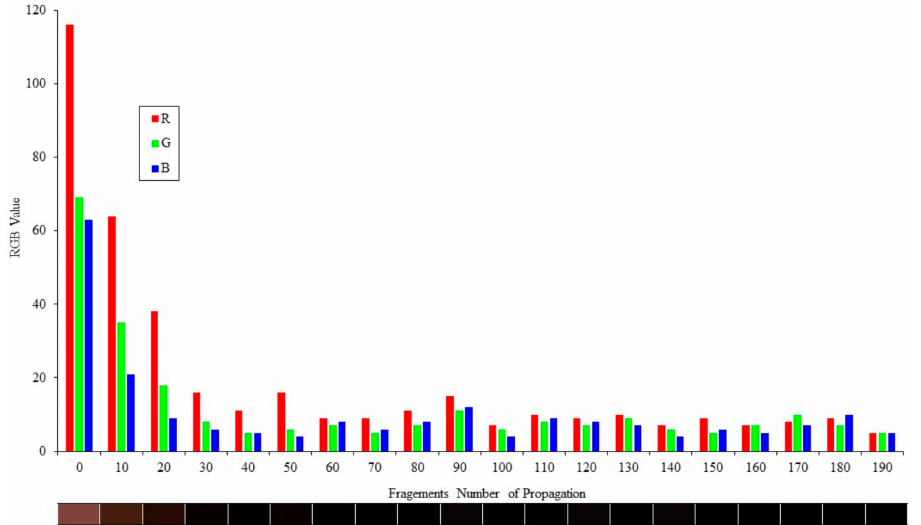
Figure 3. Quantification of the blackening of the left thumb as indicated by the RGB values af- ter propagating S. flexibilis . The horizontal color bar at the bottom is the color of the sum of the RGB values.